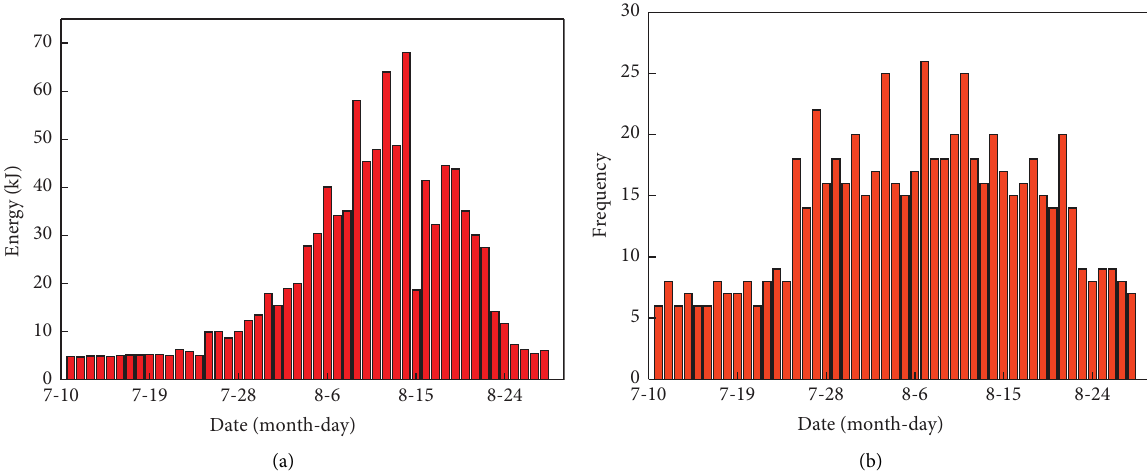
Figure 3: Energy and frequency change of caving when passing through fault. (a) Energy. (b) Frequency.